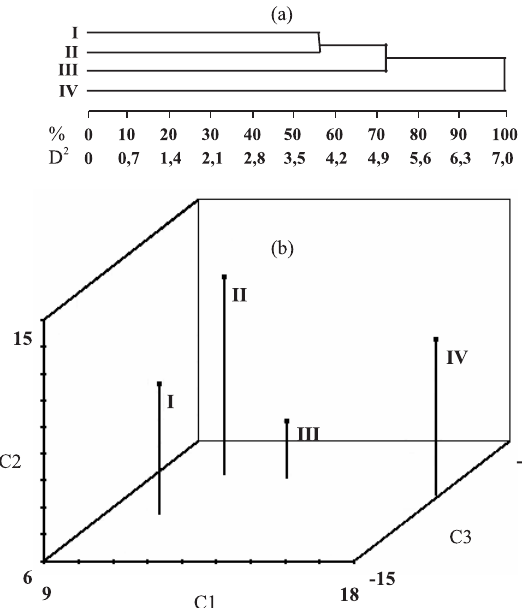
Figura 4. Análises das características químicas e fí- sicas dos solos dos diferentes locais de amostragem do sistema radicular de Epidendrum secundum por técnicas multivariadas: (a) disper- são gráfica em 3D dos locais com base nos componentes principais C1, C2 e C3, e (b) dendrograma calculado pela técnica UPGMA a partir da matriz de distância euclidiana padro-